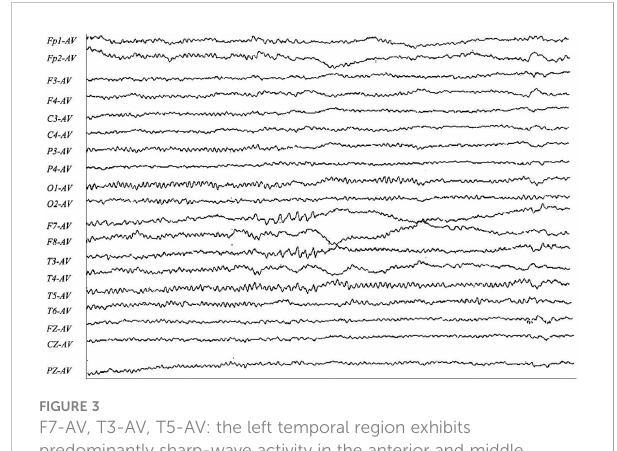
FIGURE 3 F7-AV, T3-AV, T5-AV: the left temporal region exhibits predominantly sharp-wave activity in the anterior and middle temporal regions, with some involvement of the posterior temporal region. F8-AV, T4-AV: The right anterior middle temporal region exhibits slow-wave